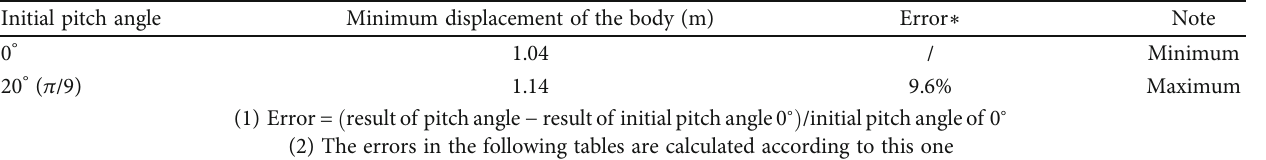
Table 8: Impact of typical working conditions of initial pitch angle on the minimum displacement of the body.